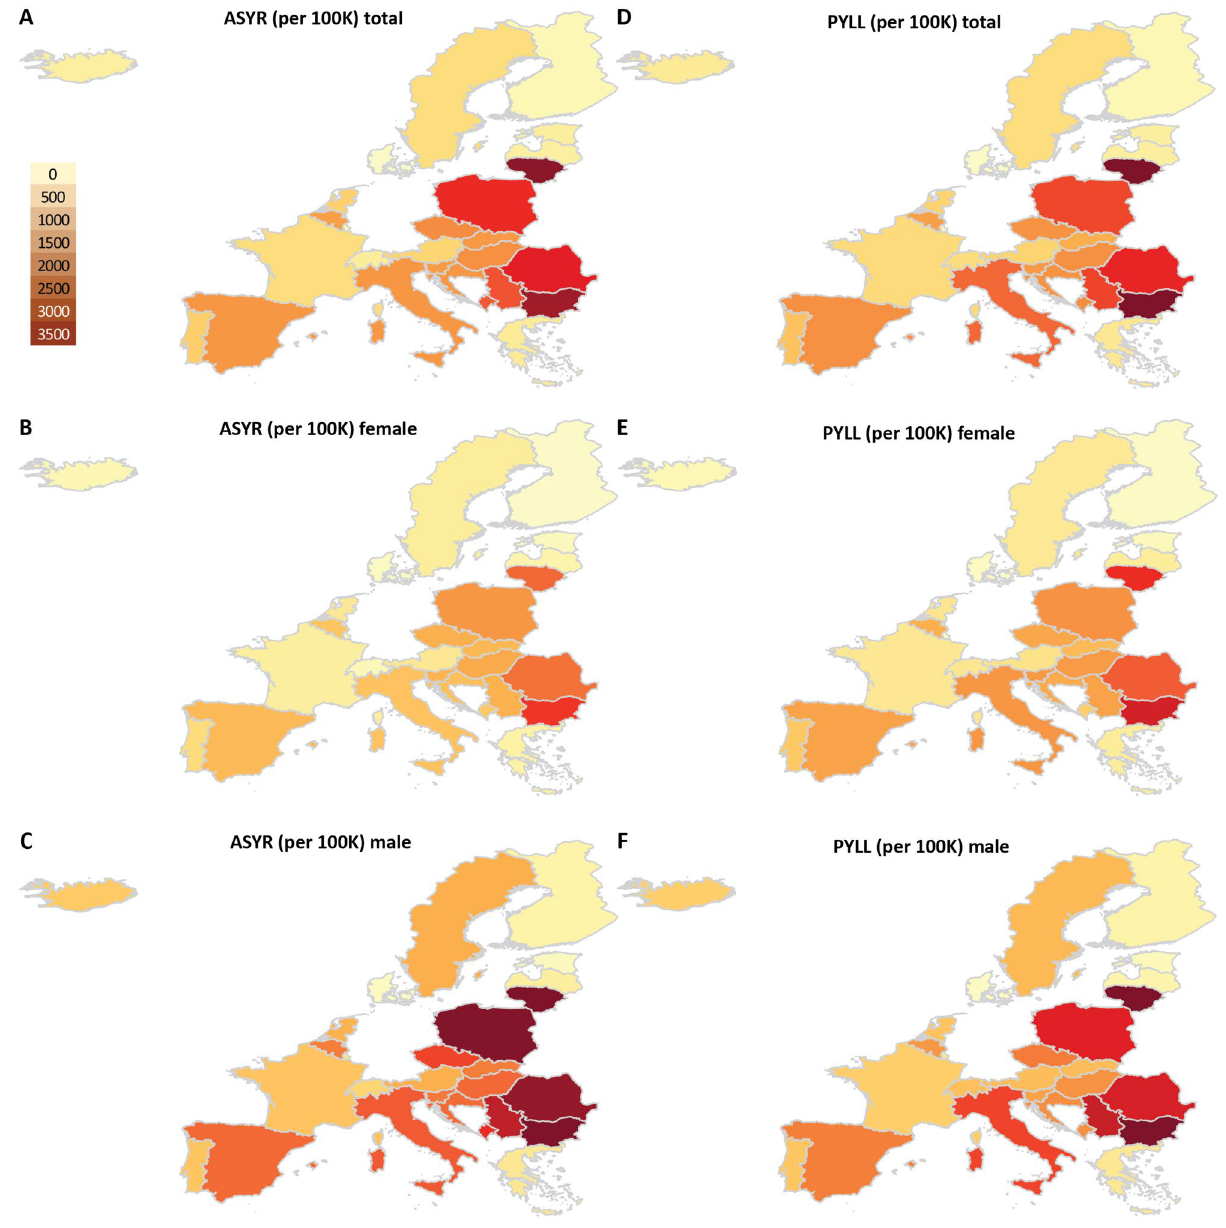
Figure 3. Geographic distribution of excess mortality-based ASYR and PYLL values for European countries in 2020. Shown are the total (per 100K people) values. ( A ) ASYR values for the whole population; ( B ) ASYR values for females; ( C ) ASYR values for males; ( D ) PYLL values for the whole population; ( E ) PYLL values for females; ( F ) PYLL values for